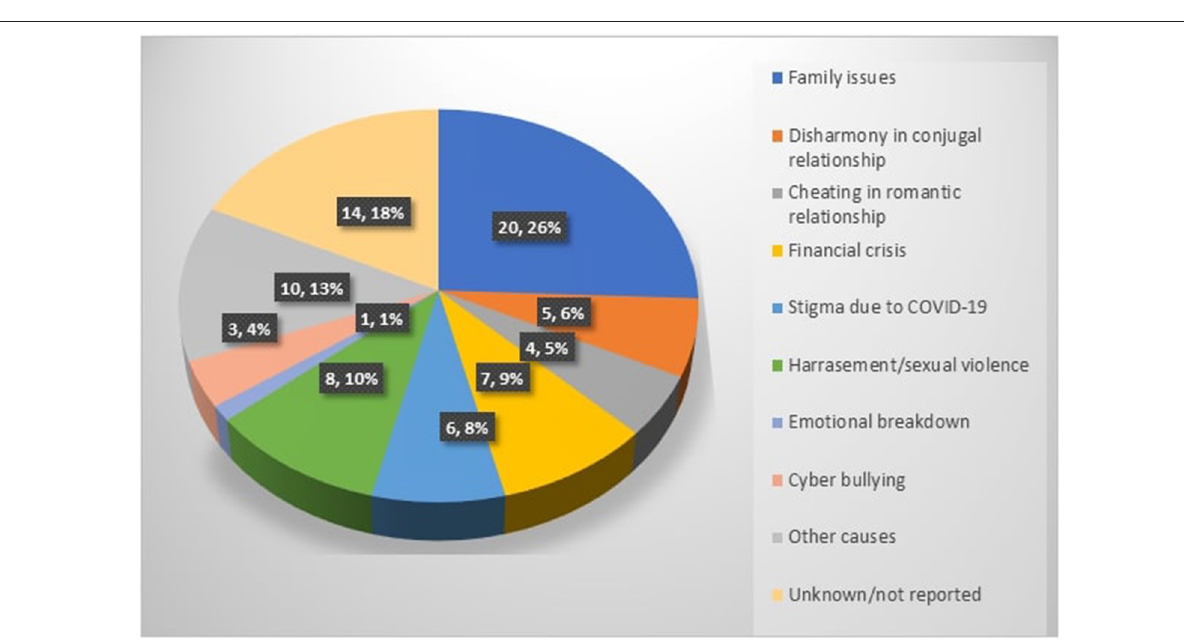
FIGURE 2 | Factors linked to newspaper reported suicidal events during